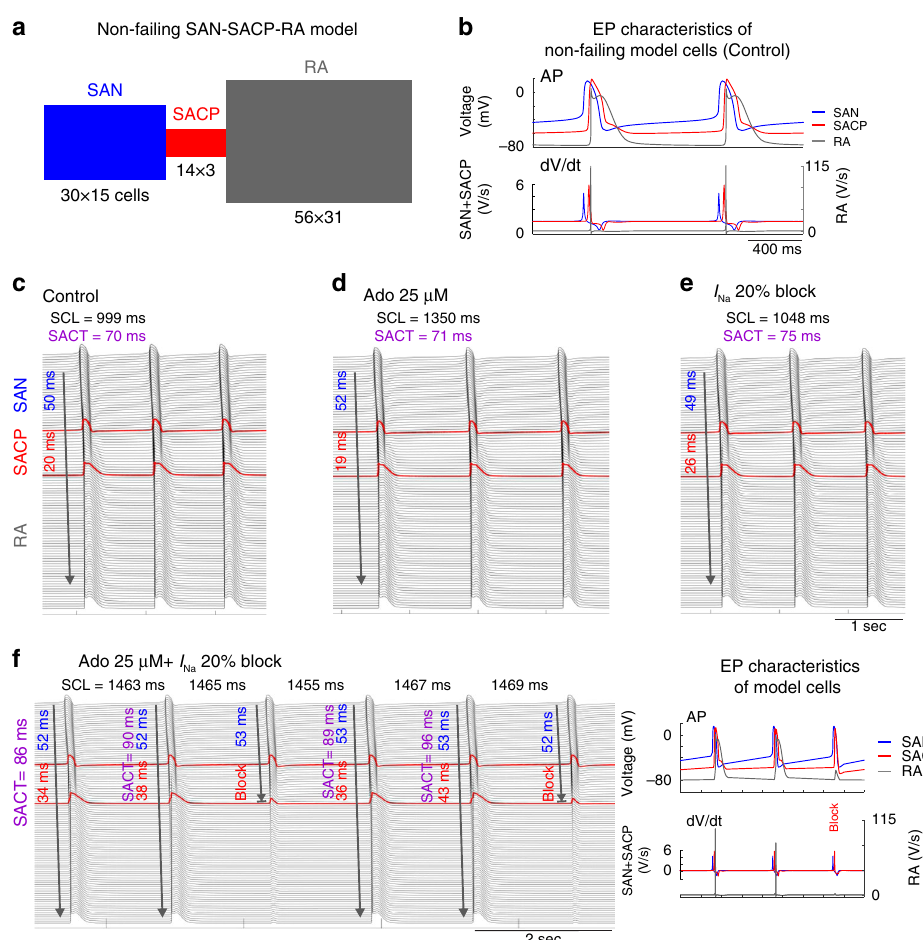
Fig. 8 Human non-failing SAN computer simulations de fi ne Nav ’ s protective role in SAN pacemaking and conduction. a Geometry of 2D computer model. b Action potentials (AP) and their derivatives (d V /d t ) show different electrophysiological (EP) characteristics of SAN, SACP, and RA cells in the current model. Propagation of APs along the middle axis of the 2D SAN-atrium are displayed from the top to bottom with time at control conditions ( c ), Ado ( d ), and sodium current ( I Na ) 20% blockade ( e ). Blue and red numbers indicate the conduction time from SAN leading pacemaker through SAN and SACP, respectively. f Left: Ado plus I Na blockade reproduced prolonged SCL and SAN exit block. Right: representative APs and derivatives. Ado adenosine, RA right atria, SACP sinoatrial conduction pathway, SACT sinoatrial conduction time, SAN sinoatrial